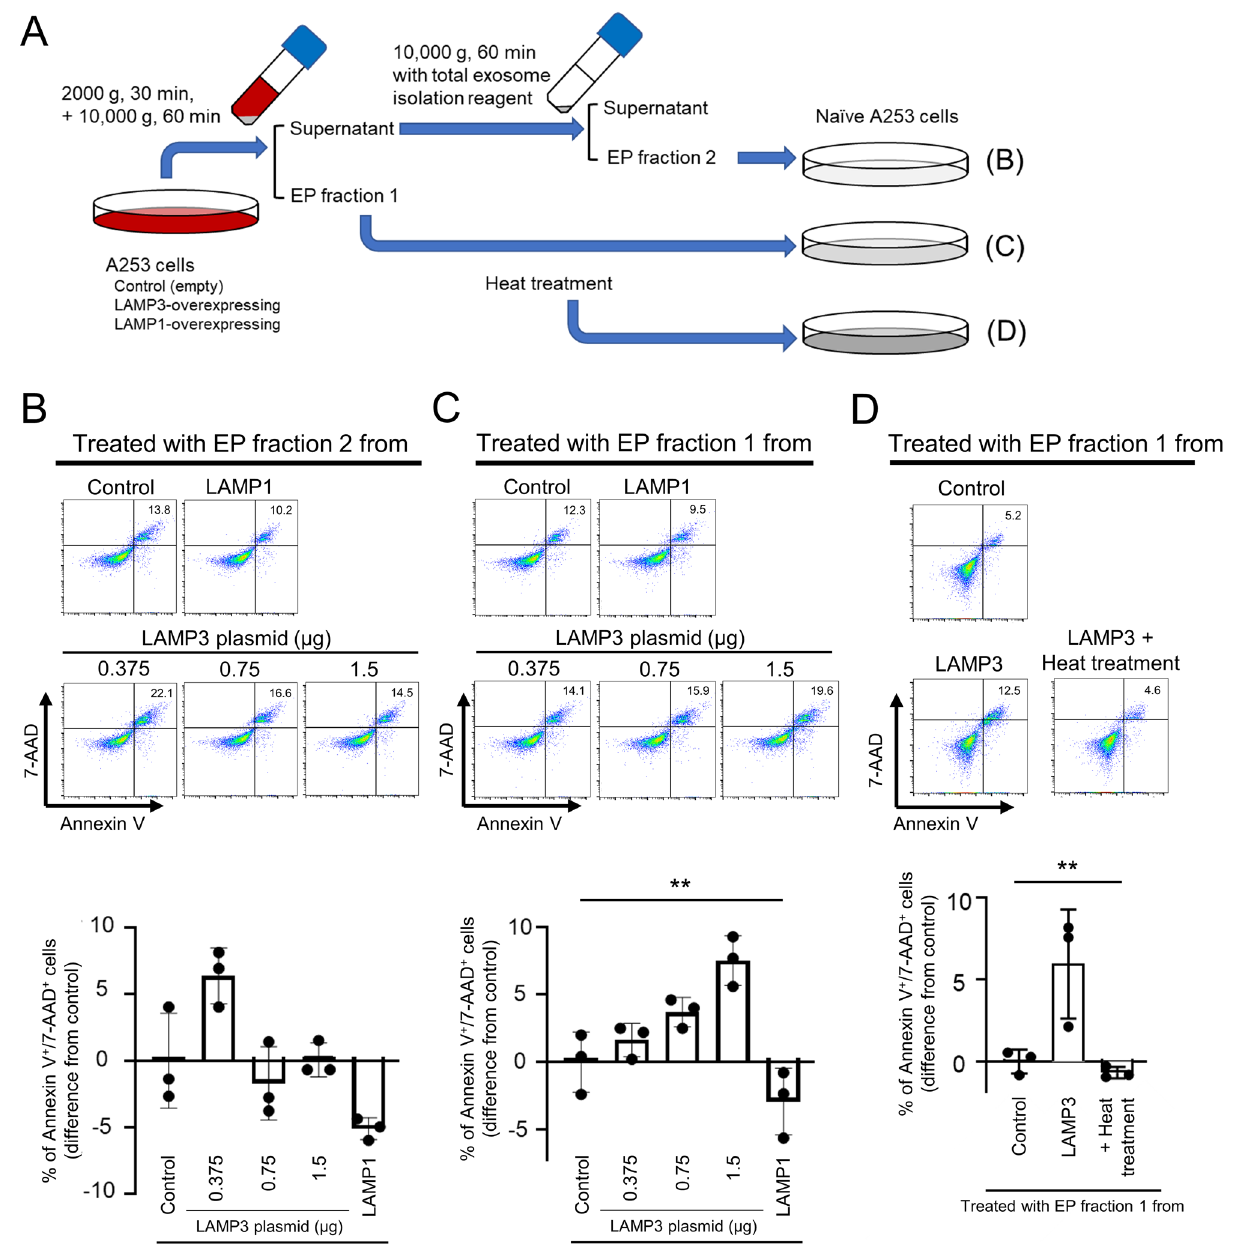
Figure 3. A fraction of extracellular particles from LAMP3-overexpressing A253 cells induces apoptosis in naïve A253 cells. ( A ) Schematic methods. Two fractions of extracellular particles (EPs) were separated from culture medium of control, LAMP3-overexpressing, or LAMP1-overexpressing A253 cells using centrifugation in combination with or without total exosome isolation reagent. Naïve A253 cells were treated with ( B ) EP fraction 2, ( C ) EP fraction 1 or ( D ) heat-denatured (heat-treated) EP fraction 1. Apoptotic cells in naïve cell culture were determined by flow cytometry using APC Annexin V/7-AAD 72 h after incubation. Graphs show difference in mean (± SD) number of Annexin V + /7-AAD + cells in cell culture compared with control ( n = 3 for all the experiments). ** p < 0.01 (one-way